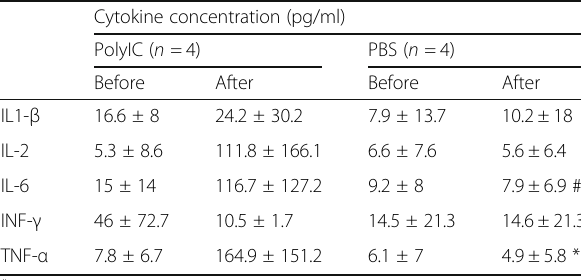
Table 2 Cytokine concentration before and 3 h after PolyIC or PBS injection in mother animals of the ferrets investigated in this study